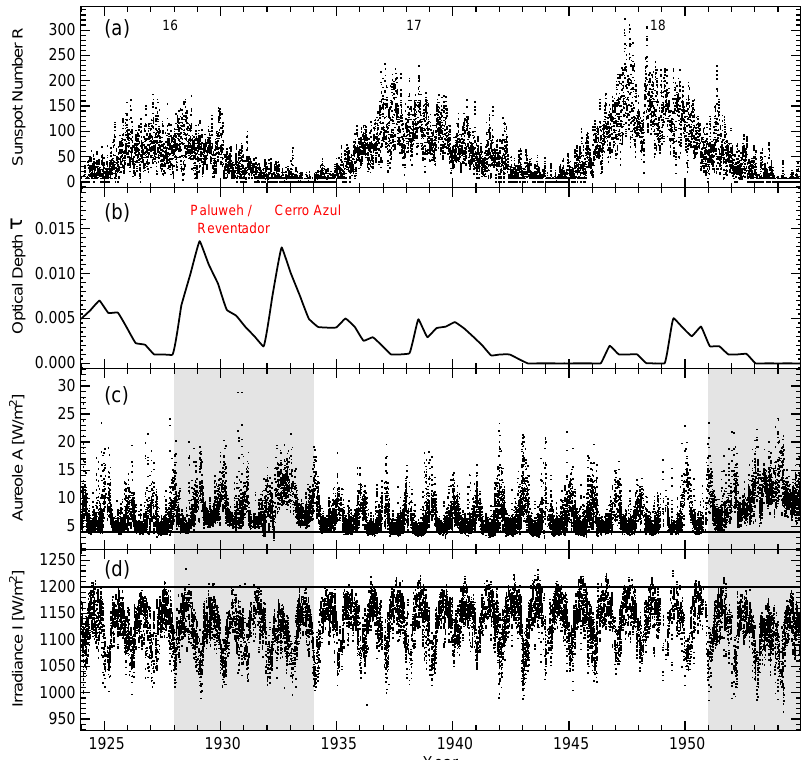
Fig. 2. Time series diagrams for (a) the daily sunspot number R for solar cycles 16 to 18, (b) the absorption by volcanic aerosols (expressed as the smoothed optical depth τ at 550nm in the Southern Hemisphere, Sato et al., 1993), (c) the brightness A of the solar aureole (pyranometry), and (d) the direct solar beam irradiance I (pyrheliometry) for Cerro Montezuma and all airmass values. Years affected by aerosols from volcanic eruptions and/or local pollution (for the years after 1950) according to Hoyt (1979) and Roosen and Angione (1984) are marked by the grey shaded areas in the lower two panels. A baseline at an arbitrary value of 4 W m − 2 (close to the annual minimum) is shown in (c) , making clear that during these times the seasonal minima of the pyranometry values are larger than normally. Similarly, an arbitrary line at 1200Wm − 2 is shown in (d) . For greater clarity, the pyrheliometry values were converted to airmass 1 using an empirically determined extinction coefficient κ = 0 . 0884 (see Sect.